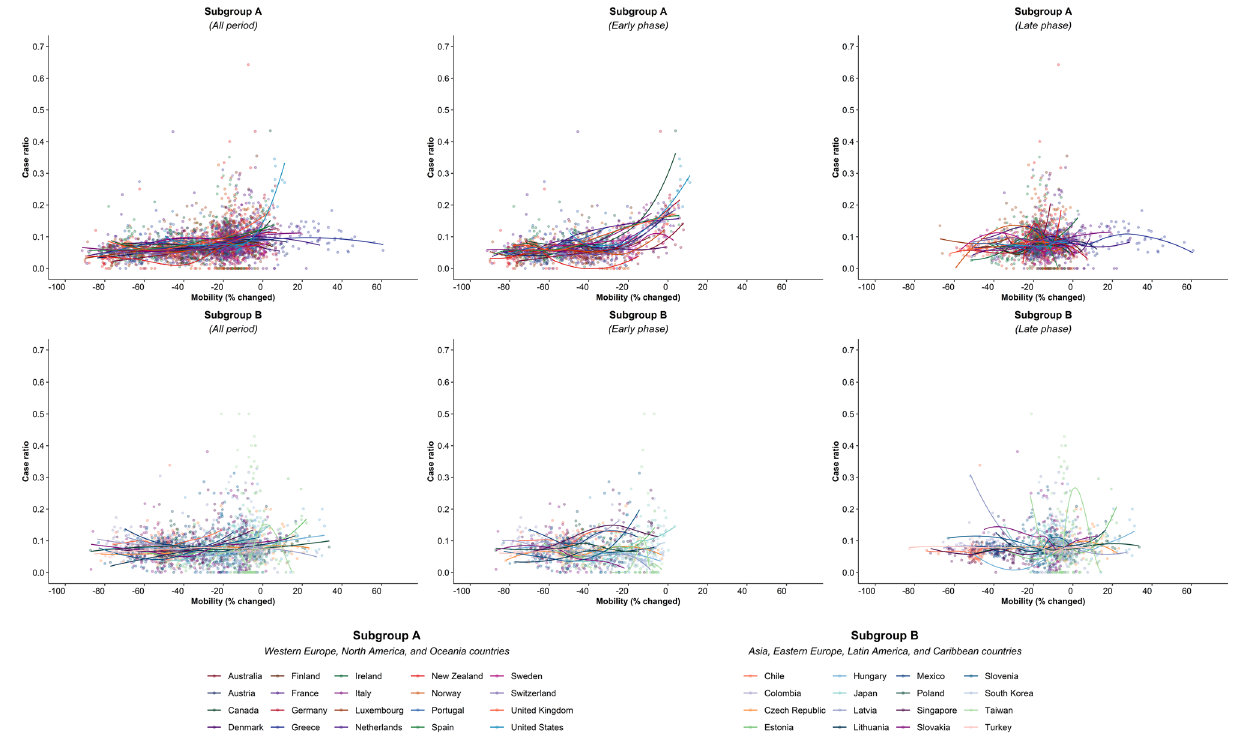
Figure 1. Association between COVID-19 case ratio and mobility changes for 36 countries by pandemic phase, arbitrarily split by geography to allow better resolution of the data. Footnote 1. The mobility change measurement period was from the day of the 100th case in each country through August 31, 2020. Footnote 2. Pandemic phase was defined for each country by the median of the date when the 100th case was detected to the end of the study period: early phase for the period before the median date and late phase for the period after the median